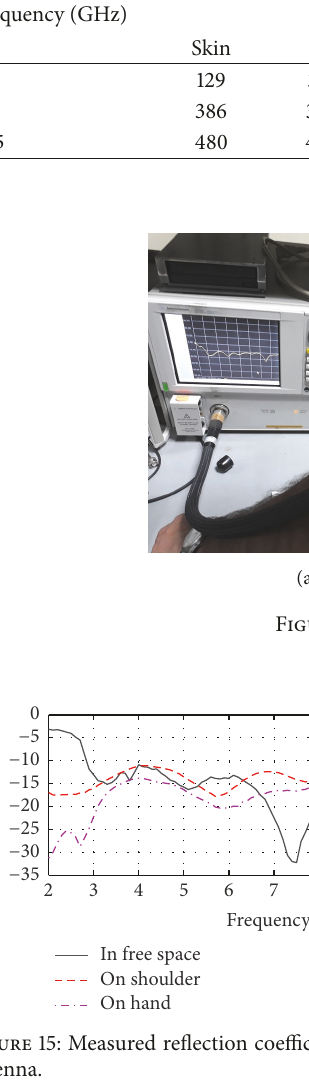
Figure 17: Radiation